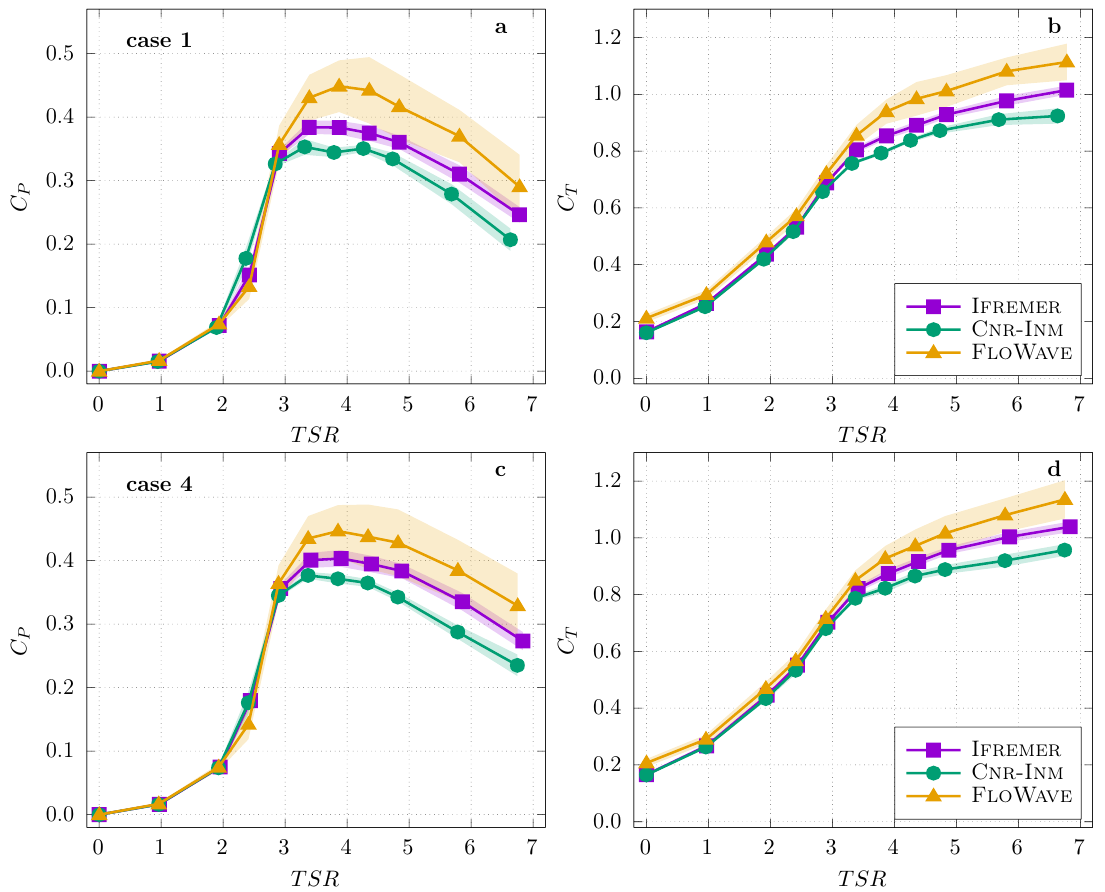
Figure 14. Power ( a , c ) and thrust ( b , d ) coefficients comparison for current-only cases: 1 at 0.8 m/s ( a , b ) and 4 at 1.0 m/s ( c , d ), versus TSR